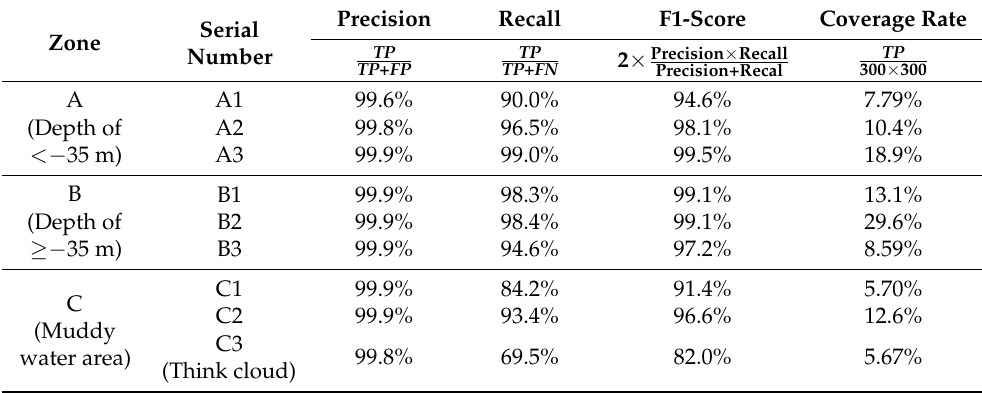
Table 6. Accuracy assessment results of the extraction effect in different